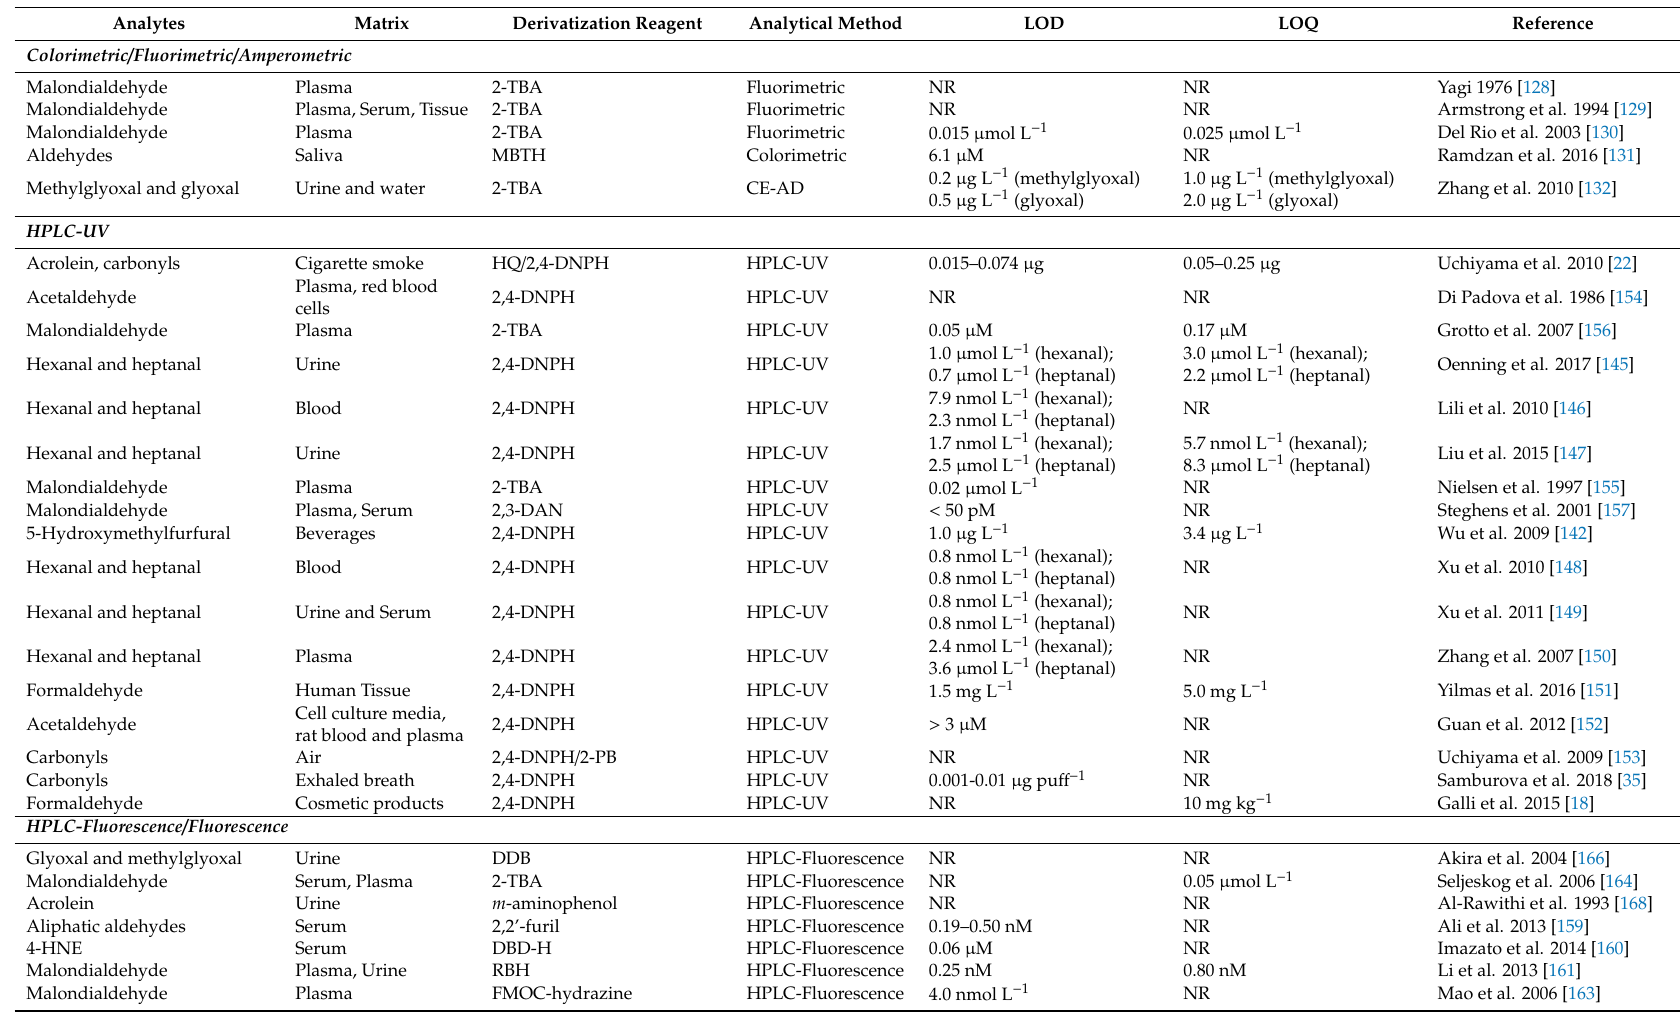
Table 2. Bioanalytical techniques for characterizing carbonyl